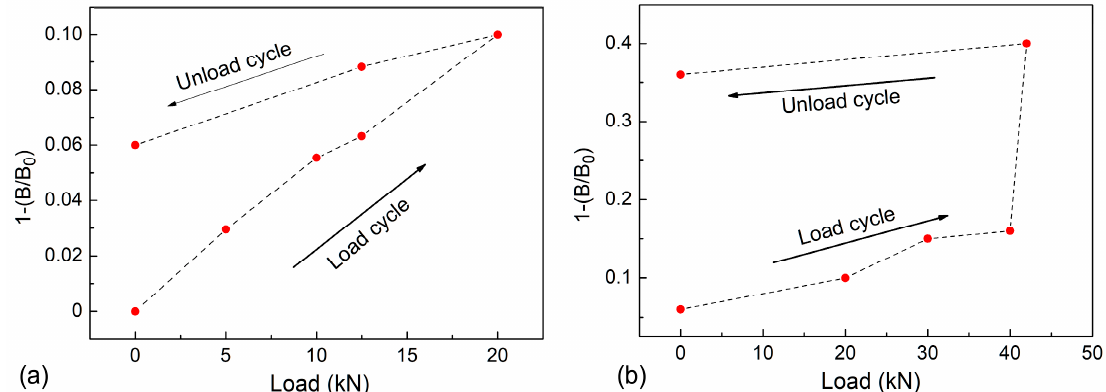
Figure 10. Normalized magnetic field signal during the load cycle up to 20 kN ( a ) and 40 kN ( b ). B is the residual magnetic field measured by the gradiometer while B 0 is the magnetization field (generally, of the order of few µT) measured before the stress test. In both graphs, a hysteretic behaviour is recorded.